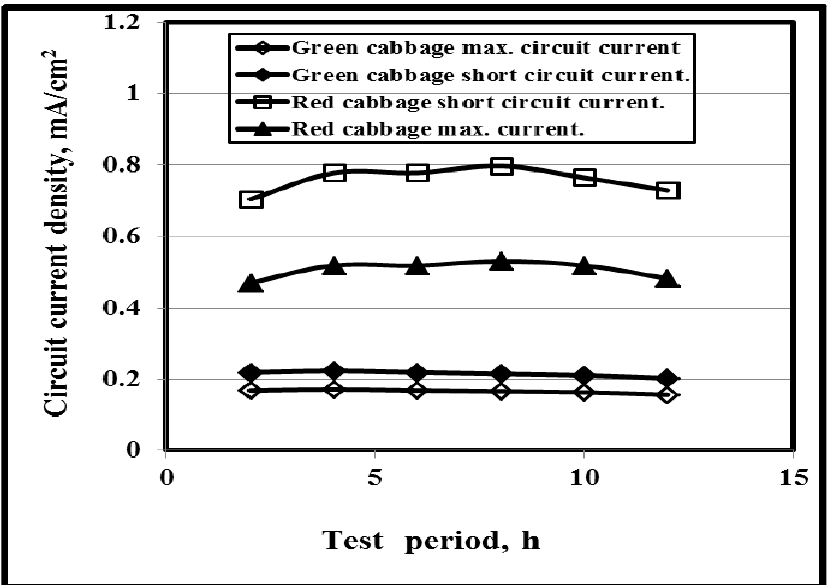
Figure 10. Im and Isc/test period for RC and GC solar cells.